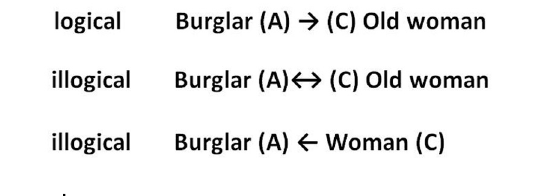
FIGURE 3 |The mental representation ofA → C CONSTRAINTS our cognitions and emotions. Once people construe the parties as A → C, the pattern of moral judgment follows a specific direction to the exclusion of all